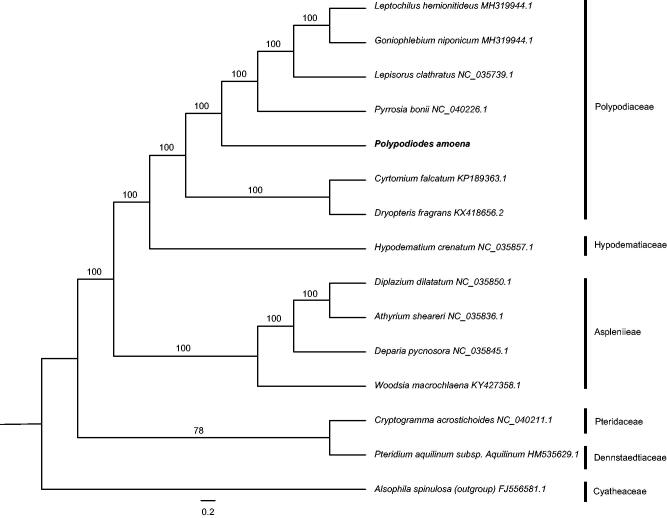
Maximum-likelihood (ML) analysis of P. amoena and other related ferns based on the complete chloroplast genome sequence with Alsophila spinulosa as outgroup. Numbers in the nodes exhibit bootstrap support values.